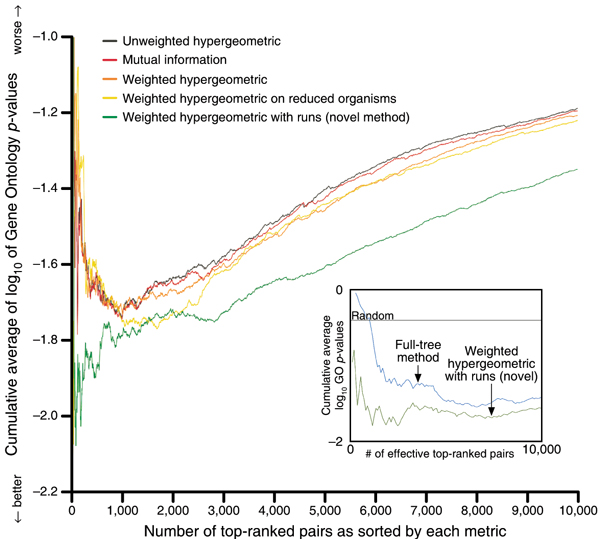
Benchmarking six methods for pairwise comparison of phylogenetic profiles. We compare six methods for ranking pairs of phylogenetic profiles. The first (black) uses the unweighted hypergeometric distribution for the probability of the observed or a greater number of matches between two profiles. The second (red) ranks by mutual information, the entropy of the first profile plus the entropy of the second profile minus the entropy of the joint profile viewed one genome at a time [3]. The third (orange) uses the weighted hypergeometric distribution that considers the occupancy of each genome across all genes. The fourth (yellow) is the same as the third but on a reduced set of organisms. The fifth (green) combines the weighted hypergeometric p-value and a p-value for the observed or a smaller number of runs in the observed matches. Methods are benchmarked against the GO cellular localization and biological process ontologies. The GO p-value for each pair of proteins is the probability for the genes of that pair to share a GO term at least as specific as their most specific shared term, and we compute the cumulative average log10 GO p-value for top pairs as ranked by each metric. Introducing runs into the calculations improves results by tending to yield more significant GO p-values. The inset compares the fifth method (green) to a full tree-based method (blue). Due to the computational difficulty of evaluating Pagel's method, we only compared it to our novel method on a random subset of 100,000 benchmarkable pairs. Each such sampled pair represents approximately 35 pairs in a full all-versus-all run. The average log10 GO p-value over all benchmarkable pairs is approximately -0.40 and is shown in the inset (but lies above the top of the main plot).